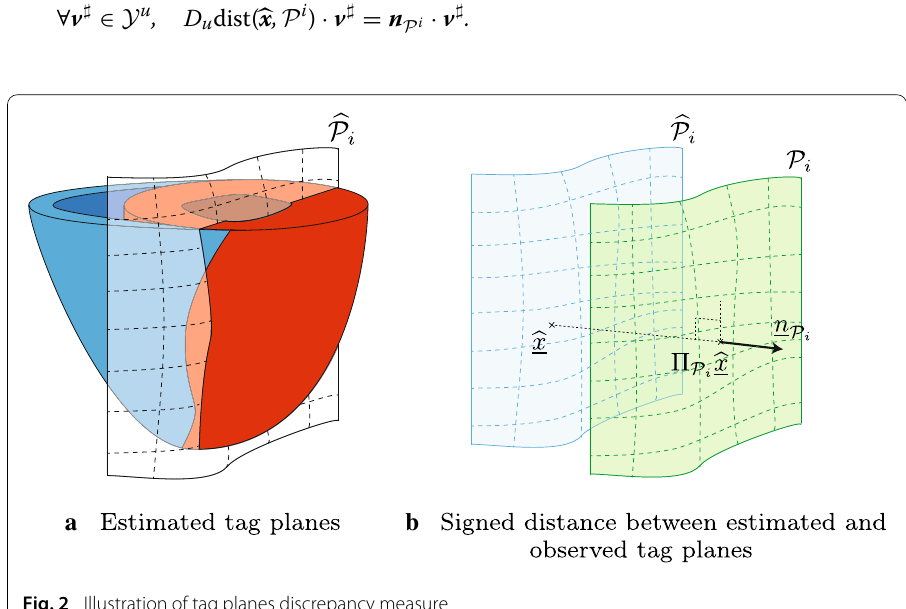
Fig. 2 Illustration of tag planes discrepancy